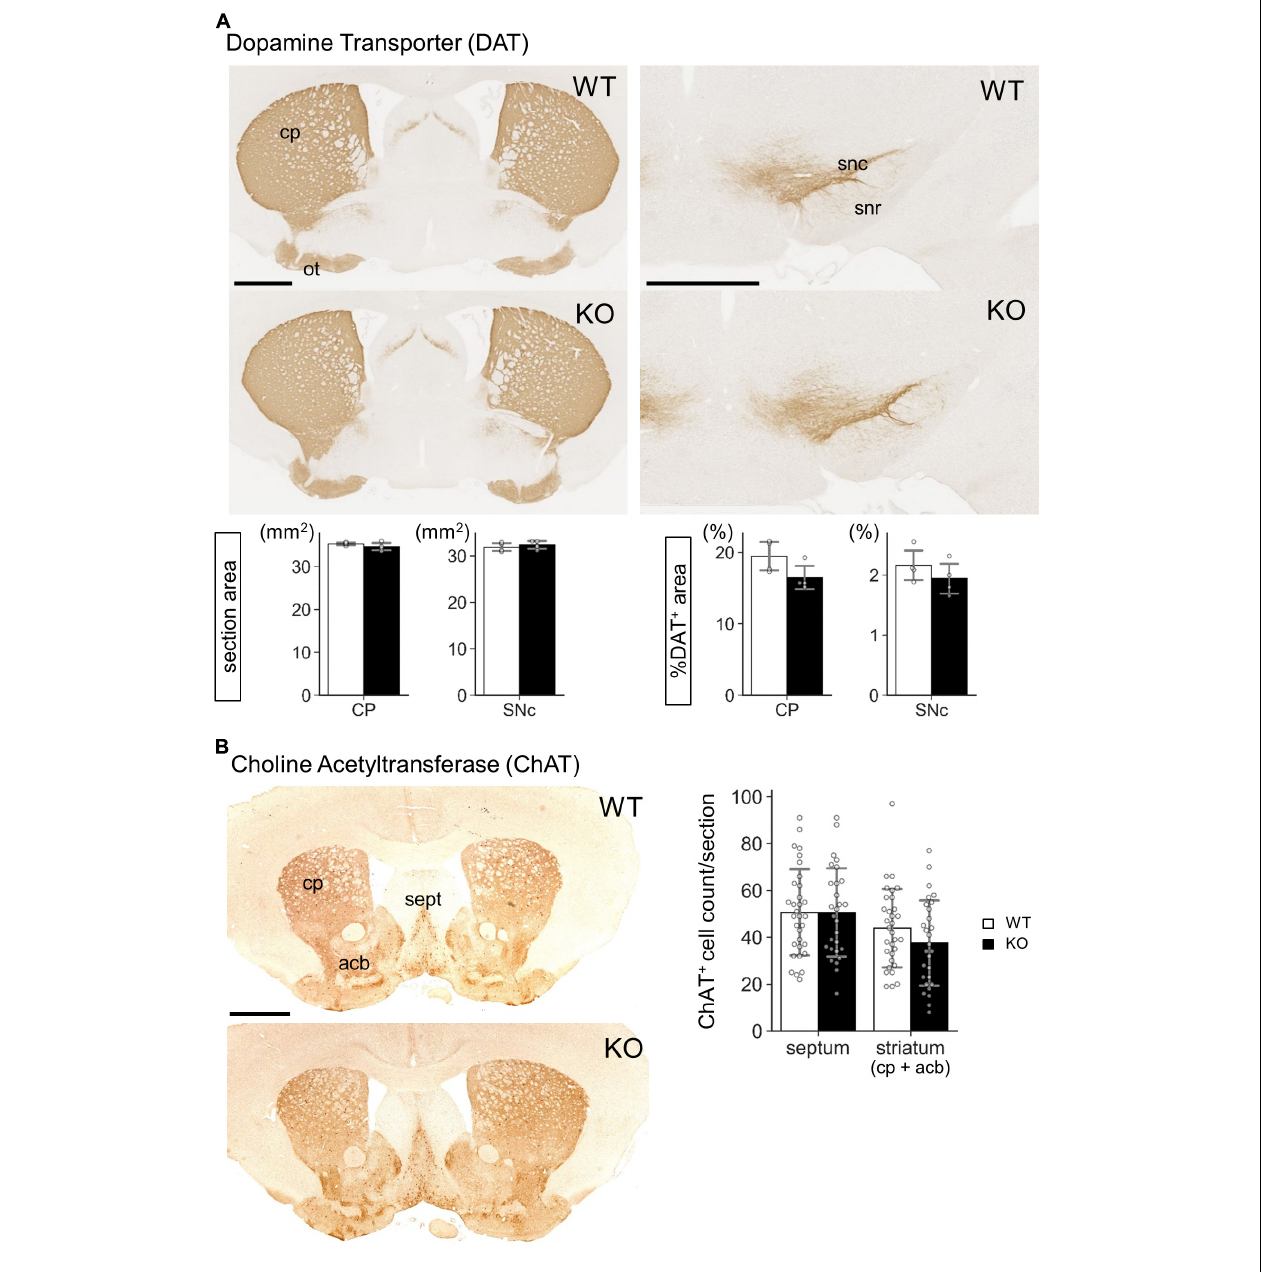
FIGURE 7 | Gross morphology of Lrtm2 KO striatum and substantia nigra. Immunostaining of Lrtm2 WT and KO mouse brains using (A) anti-dopamine transporter (DAT) antibody or (B) anti-choline acetyl transferase (ChAT) antibody. (A) DAT immunostaining. Left-graphs , entire areas of coronal sections through CP or SNr. Right-graphs , areas of DAT-immunopositive areas are indicated as percentages to entire section areas. n = 4 mice for each genotype. Mean of 4 images was used for a mouse. (B) ChAT immunostaining. Graph , quantification of ChAT-immunopositive cell numbers in septum or in striatum. n = 32 or 28 sections from 4 mice for each genotype. Error bars , SD. There were not significant differences between WT and KO in either region. acb, nucleus accumbens; cp, caudoputamen; ot, olfactory tubercle; sept, septum; snc, substantia nigra pars compacta; snr, substantia nigra pars reticulata. Scale bars , 1